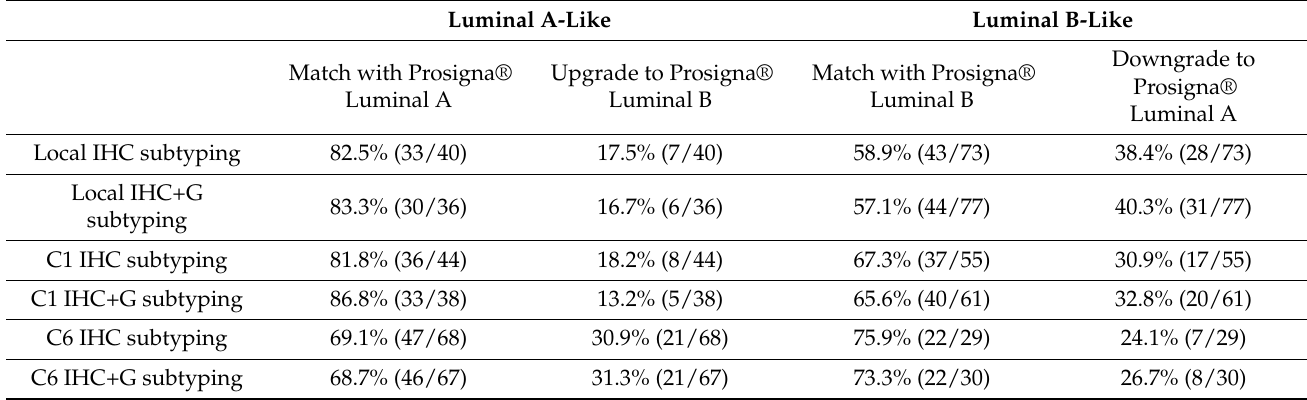
Table 2. Comparison between local vs. C1 vs. C6 surrogate subtyping and molecular Prosigna® subtype.